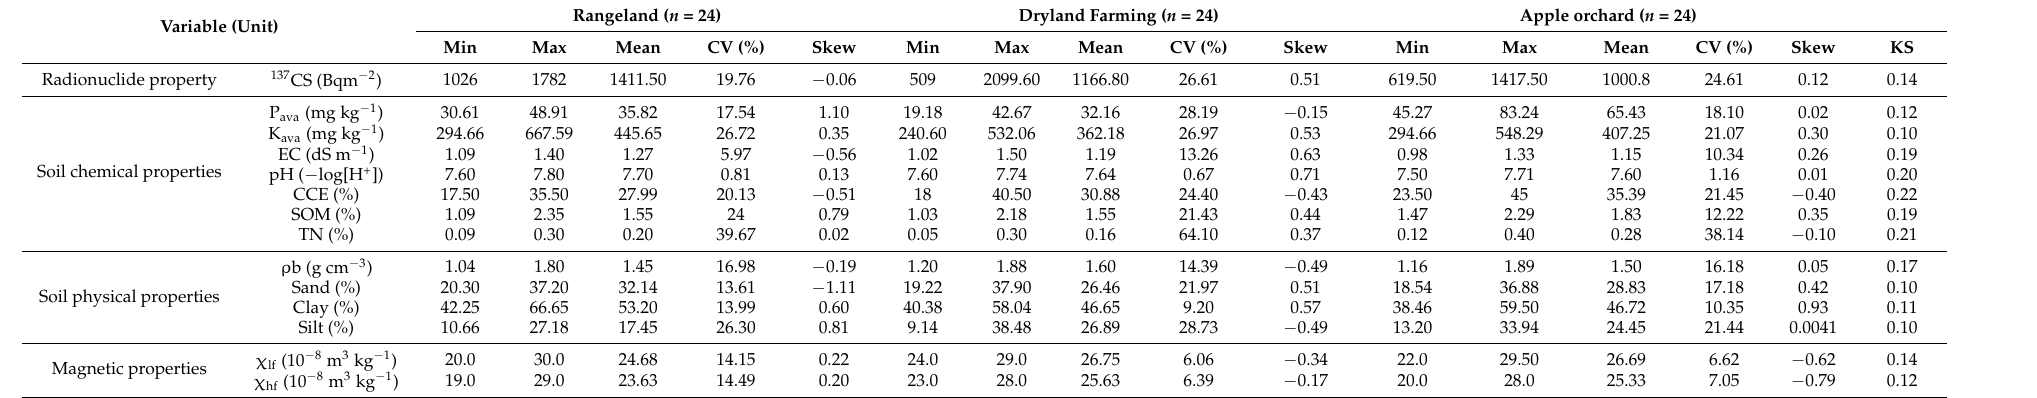
Table 1. Descriptive statistics of studied variables in three selected land